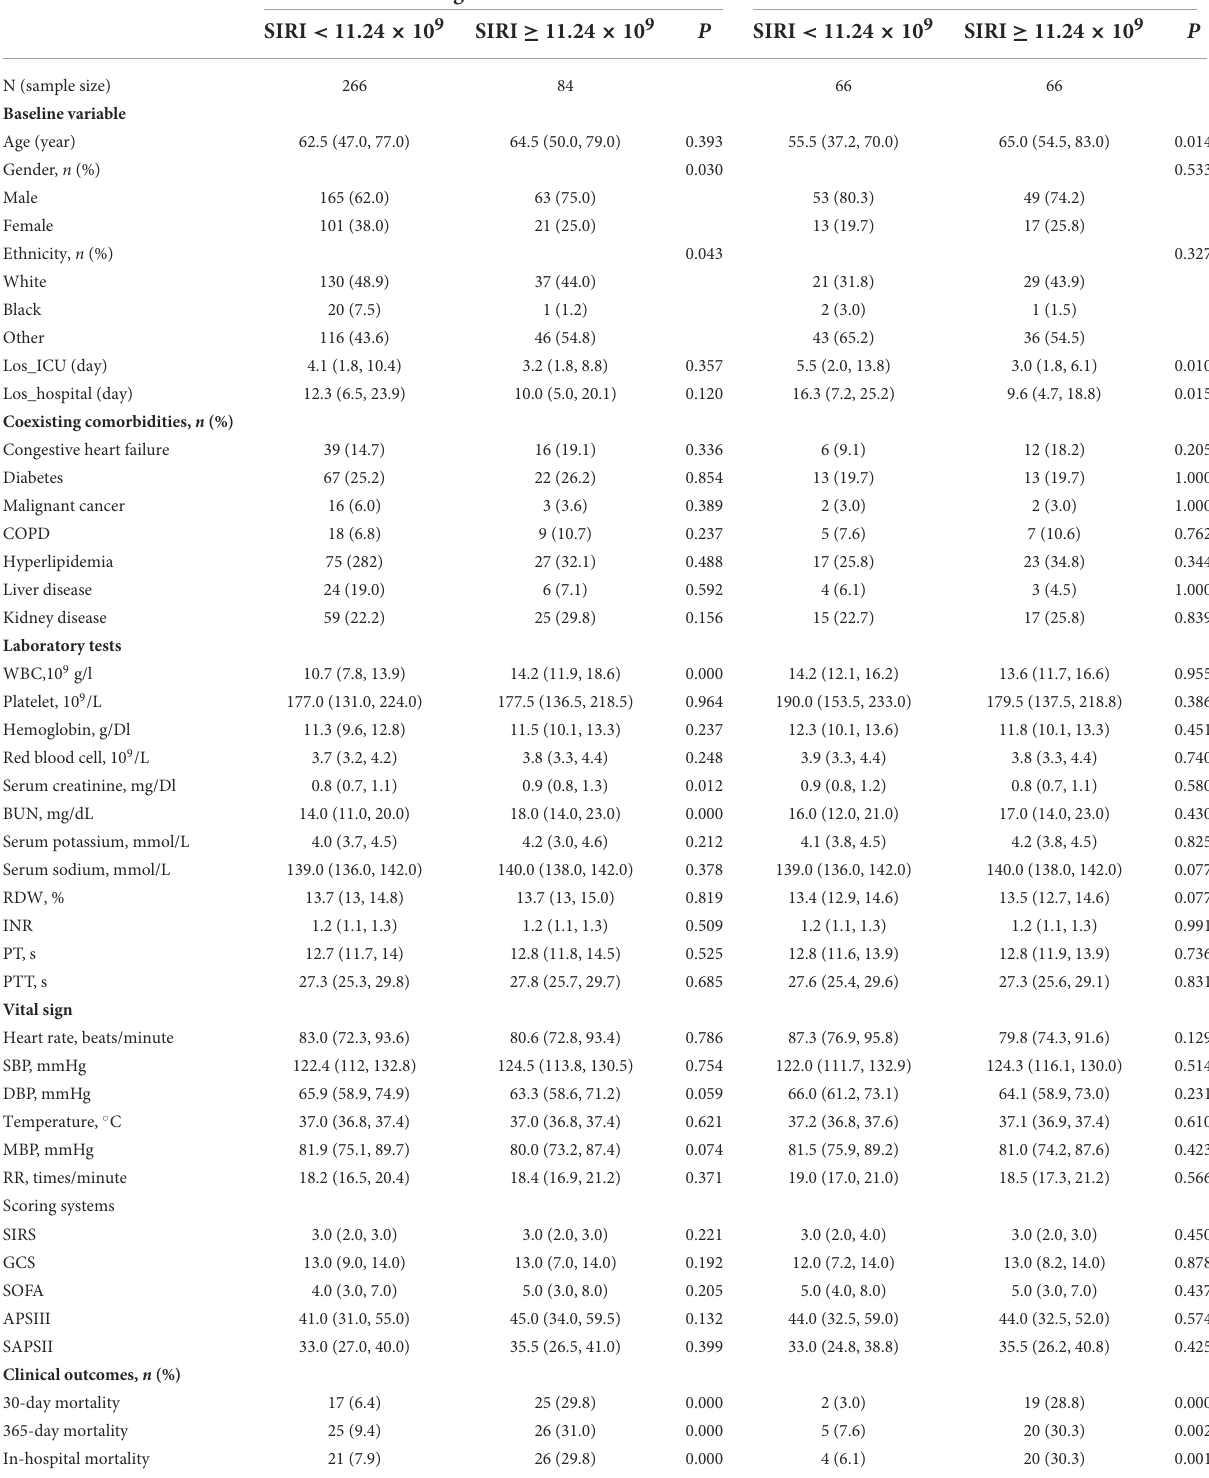
TABLE 1 Characteristics of the study patients according to the SIRI groups before and after PSM.